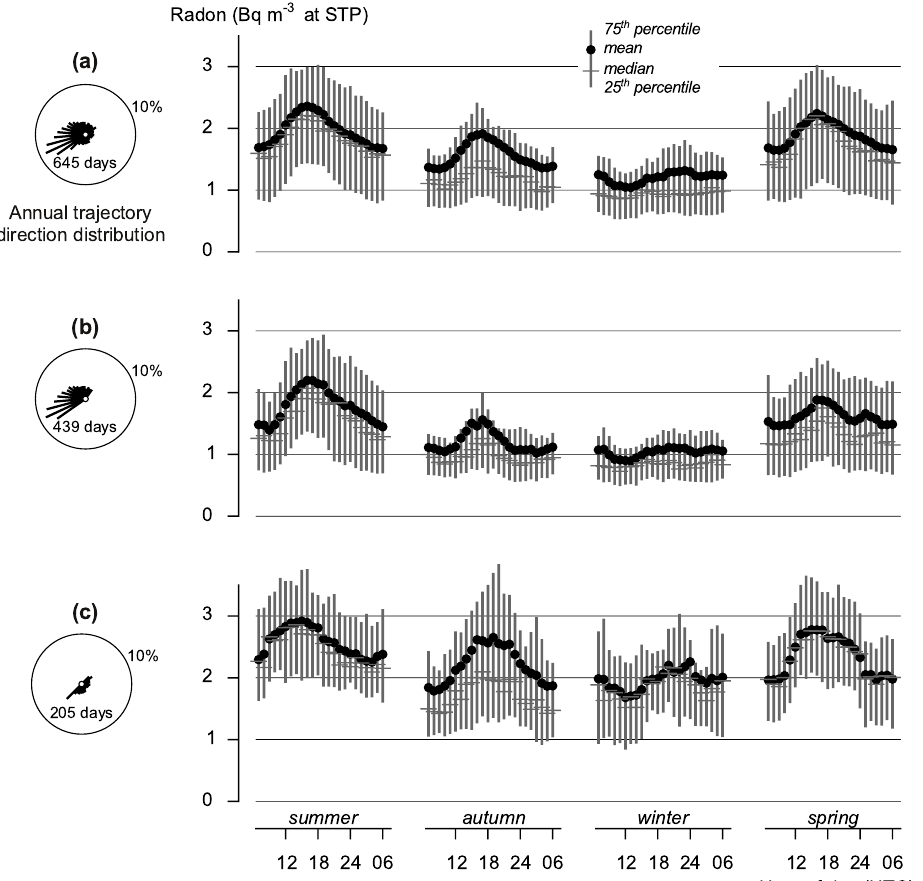
Figure 4. Radon diurnal and seasonal cycle. The plots show the mean (dot), median (horizontal bar) and 25th–75th percentile range (vertical bar) of each bin. The synoptic-scale wind direction is calculated from the back-trajectory position at a distance of 61km (the distance between Bern and Jungfraujoch). Plots in (a) show all directions, in (b) show air arriving from the north-western side of the Alps (which are aligned south-west to north-east), and in (c) show air arriving from the south-east after passing over the full width of the